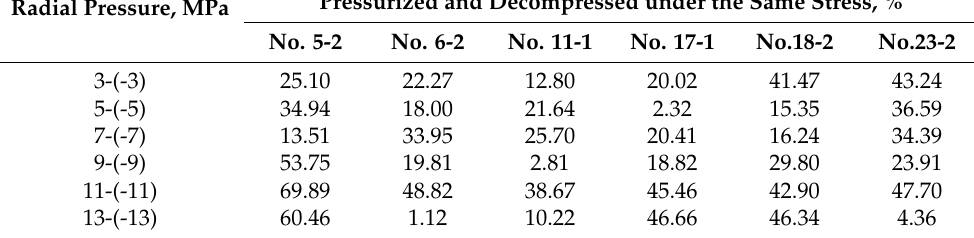
Table 1. Variation amplitude of pores and fractures in cores under pressure and decompression under the same stress. Radial Pressure,